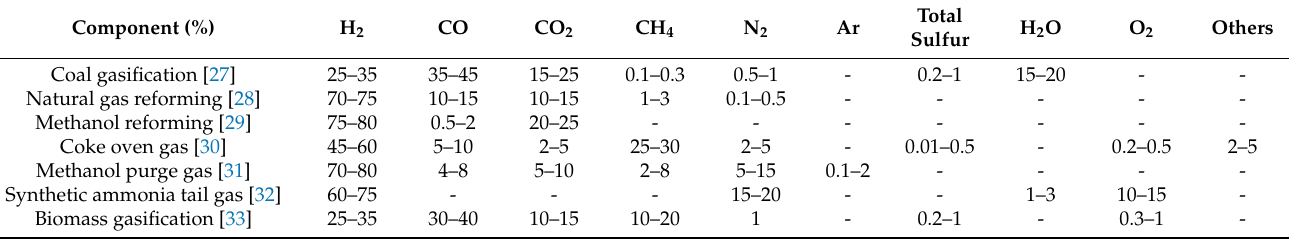
Table 4. Composition of different types of crude